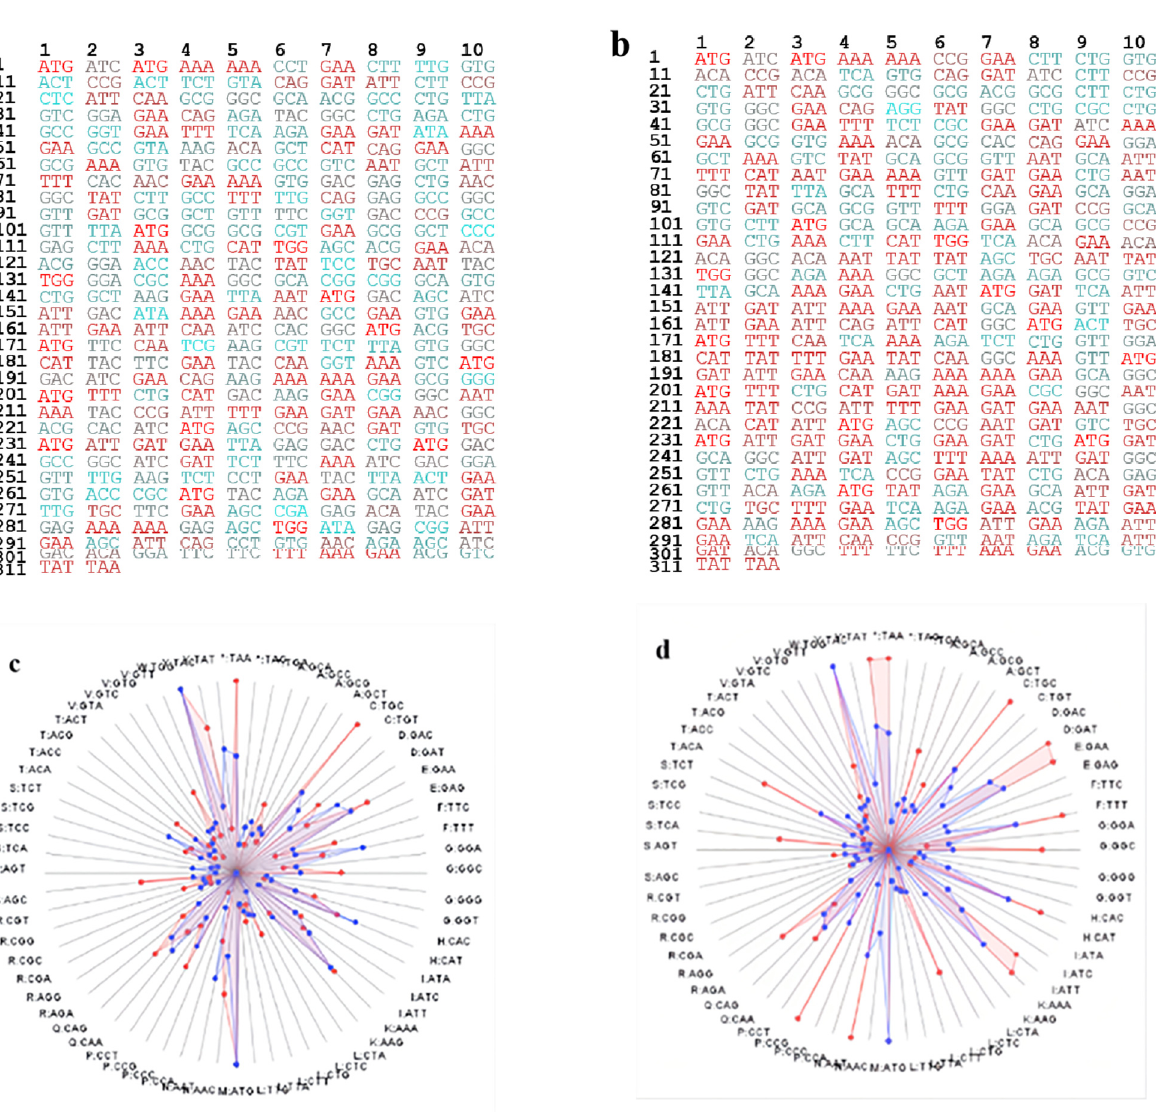
Figure 1. ( a ) Original sequence. ( b ) Optimized sequence. Relative codon frequency distribution. Color of codons indicates the frequency of that codon with respect to the host. Rarely used codons are shown in cyan and frequently used codons are shown in red. A redder codon indicates higher frequency. Redder codons compared with the other codons mean that they are better suited for the host codon bias, resulting in high expression. ( c ) Original sequence. ( d ) Optimized sequence. Codon relative frequency radar plot. The relative codon frequency distribution shows the frequency of each individual codon and this radar plot shows the suitability of the codon usage profile between the optimized sequence (show in red) and host (shown in blue). A better curve match means it is more adequate.